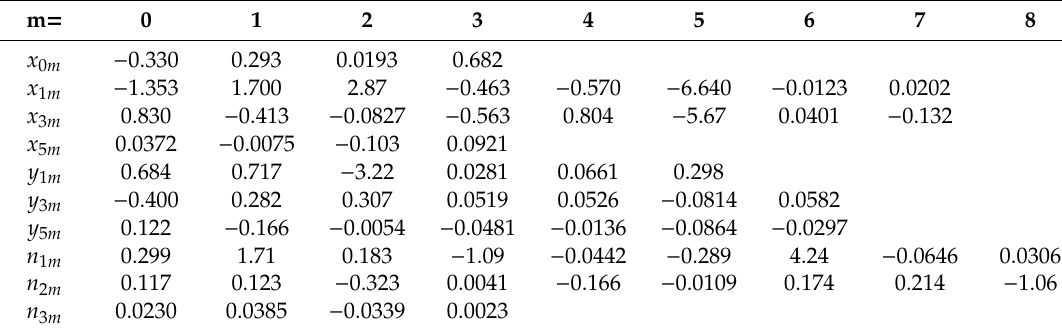
Table 1. Each coe ffi cient of independent